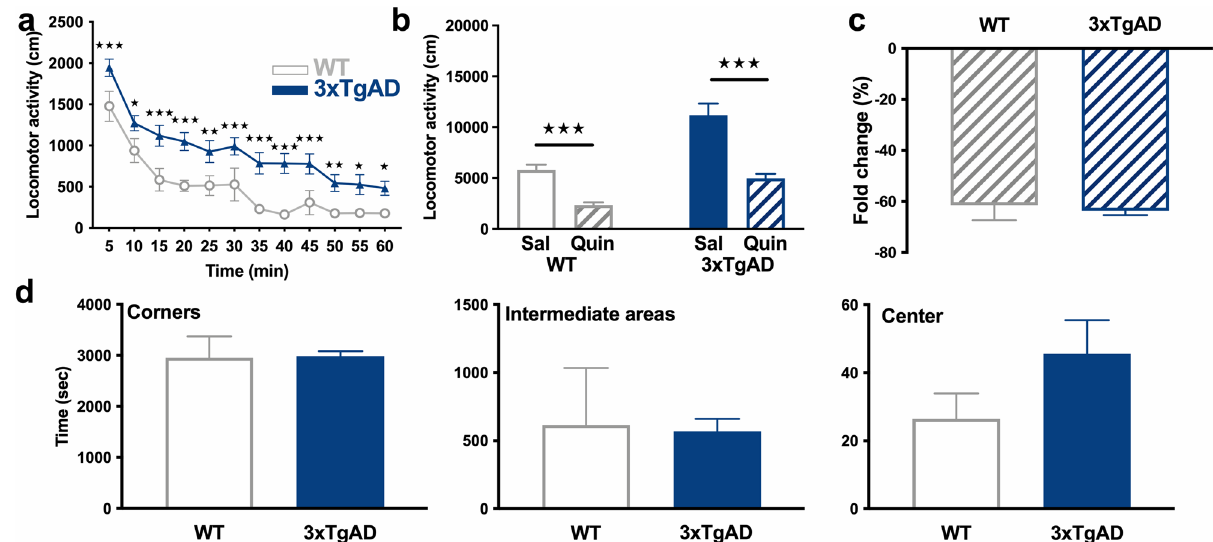
Figure 6. No dopaminergic-related behavioral alterations in 4-month-old 3xTg-AD mice. (a) Locomotor activity of WT (grey, open circles) and 3xTg-AD (blue, triangles) mice at baseline in 5 min blocks. (b) Total distance traveled, in response to saline (Sal) and quinpirole (Quin) in WT and 3xTg-AD mice. (c) Fold change in locomotion induced by quinpirole as compared to saline. (d) From left to right, time spent in corners, intermediate areas and central square of the open field during the baseline test in WT and 3xTg-AD mice. : p < ★★★